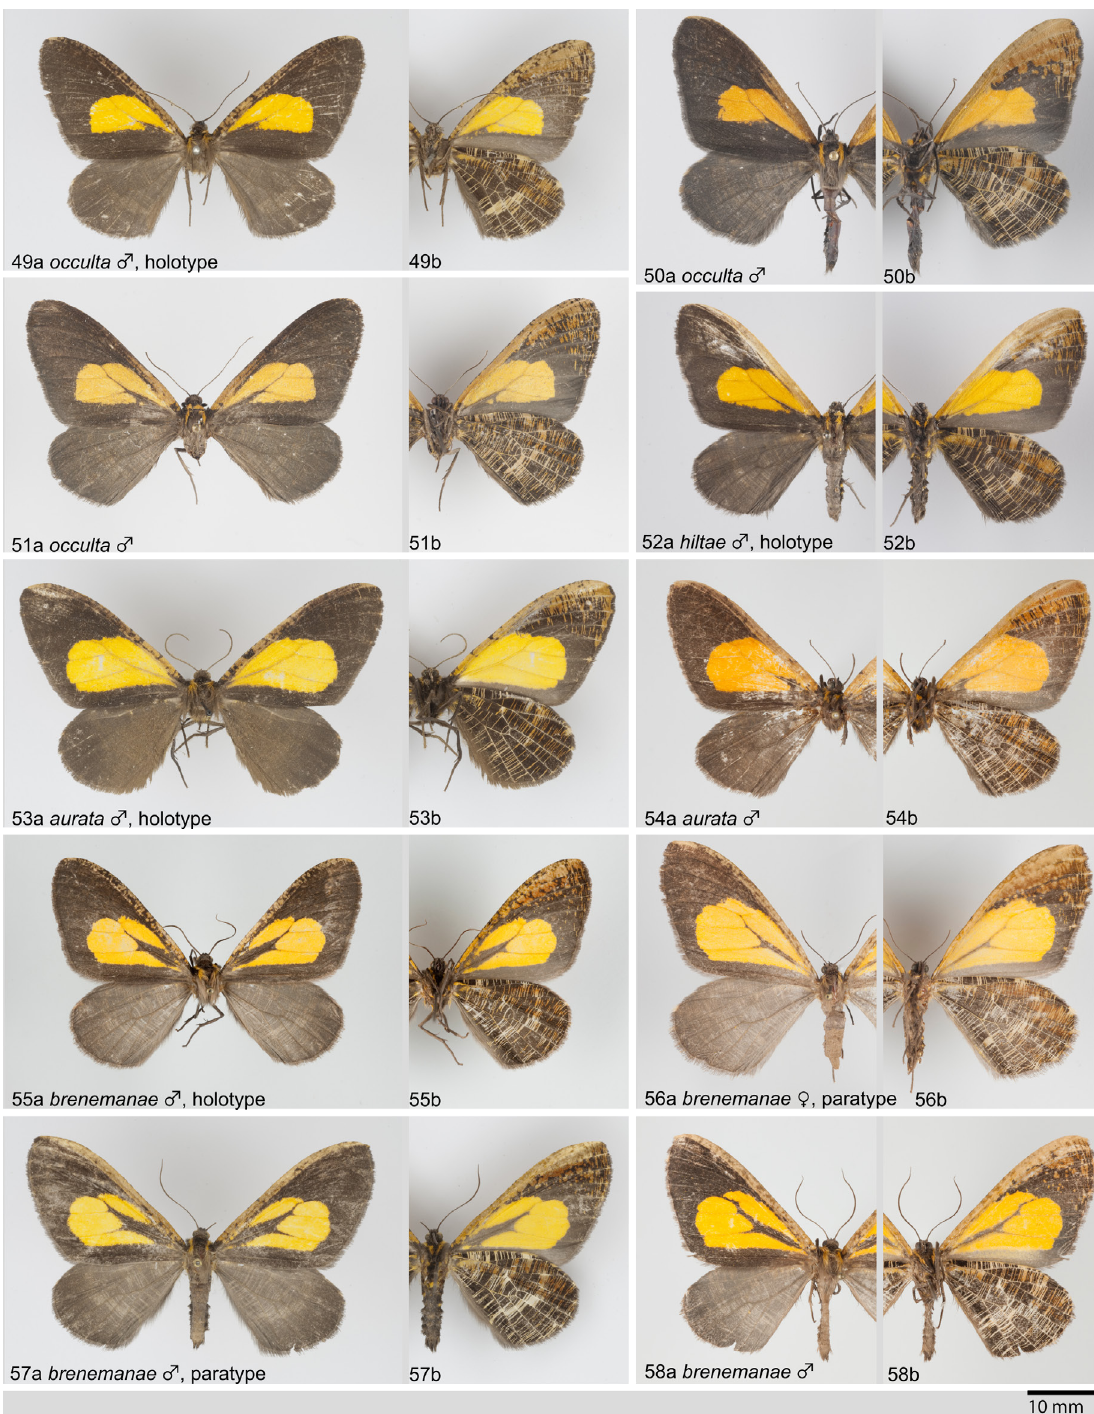
Figs 49–58. Adult moths (a = dorsal view; b = ventral view). 49 . Callipia occulta Warren, 1904 stat. rev., ♂, holotype (NHM). 50 . C. occulta Warren, 1904 stat. rev., ♂ (C-0159, COI data). 51 . C. occulta Warren, 1904 stat. rev., ♂ (C-0084, COI data). 52 . C. hiltae sp. nov., ♂, holotype (C-0153, COI data). 53 . C. aurata Warren, 1904, ♂, holotype (NHM). 54 . C. aurata Warren, 1904, ♂ (C-0087, COI data). 55 . C. brenemanae Sperry, 1951, ♂, holotype (C-0129). 56 . C. brenemanae Sperry, 1951, ♀, paratype (C-0130). 57 . C. brenemanae Sperry, 1951, ♂, paratype (NHM; C-0131). 58 . C. brenemanae Sperry, 1951, ♂ (C-0084, COI